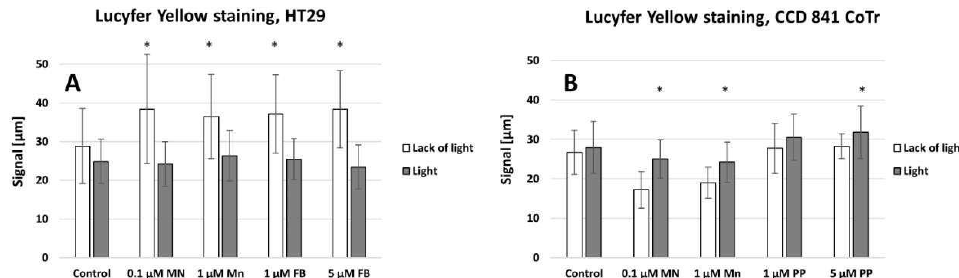
Figure 11. The signal transmitted between cells ( A )—HT29 and ( B )—CCD 841 CoTr. Columns and bars show the mean ± standard deviation (n = 3). Statistical significance was analysed at p < 0.05. * Statistical significance in comparison to appropriate control at p < 0.05.